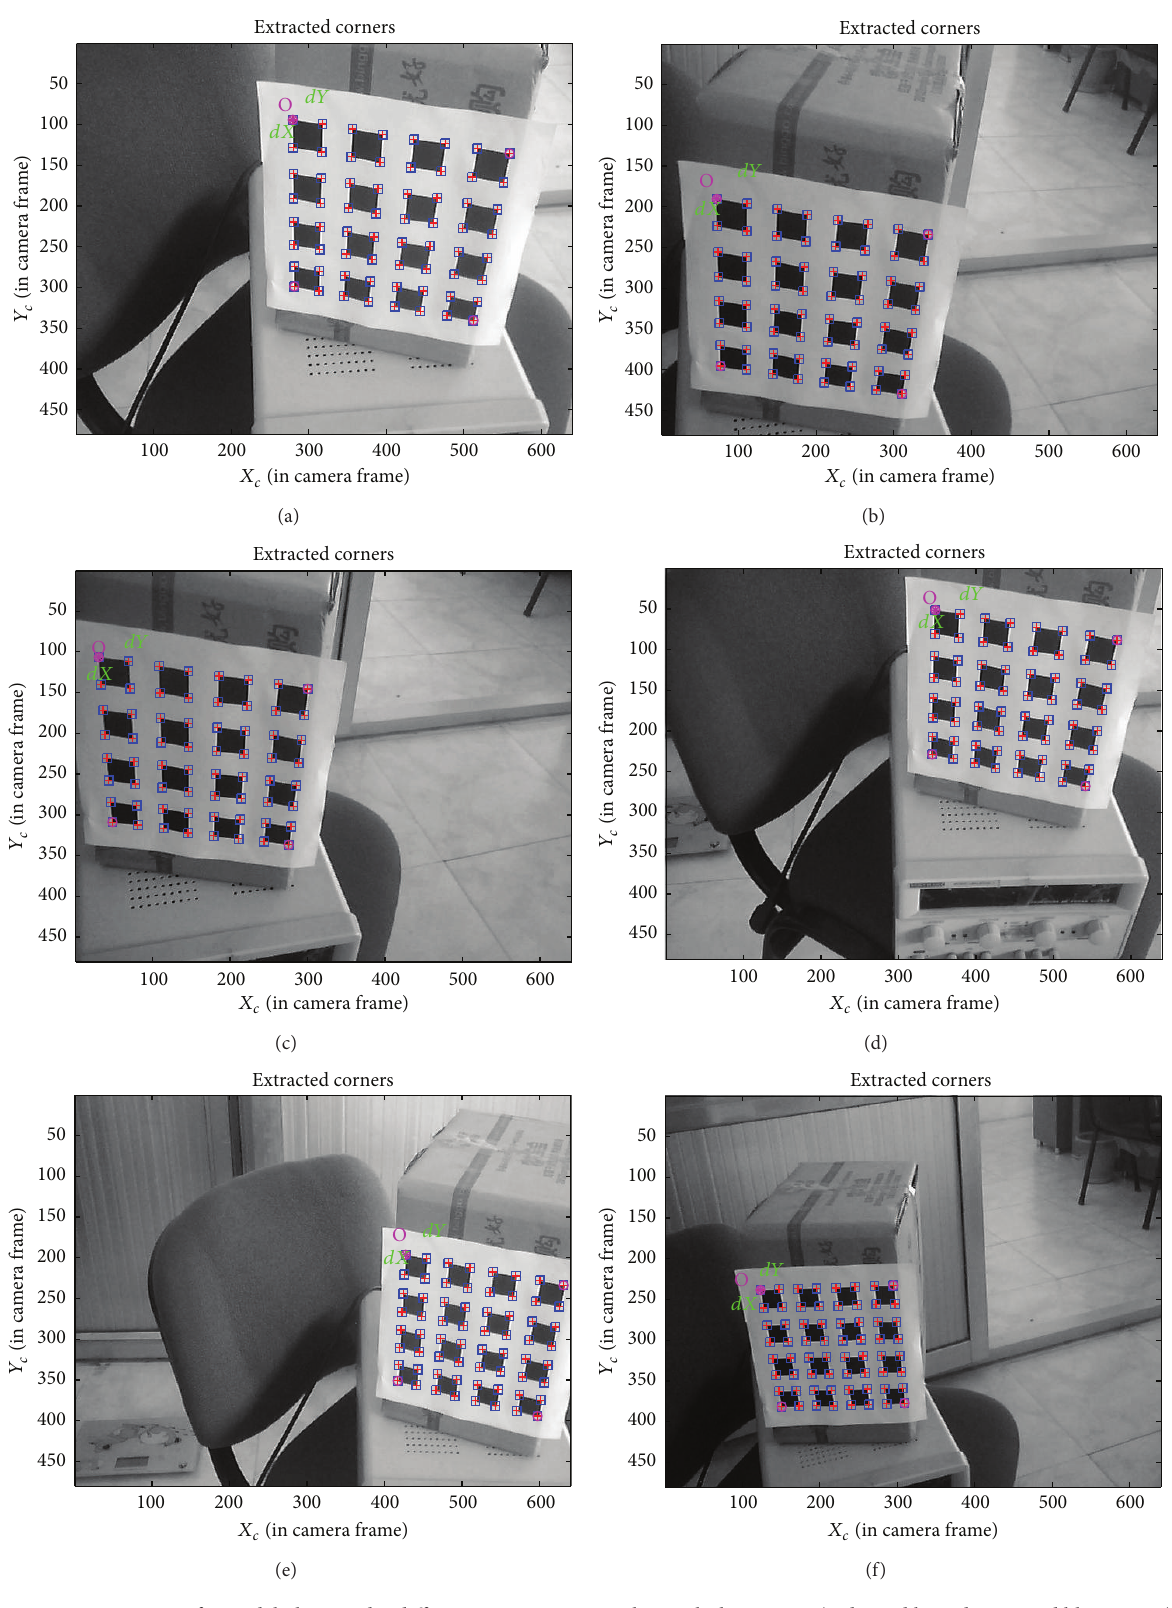
Figure 6: Six images of a model plane under different orientation, together with the corners (indicated by red cross and blue